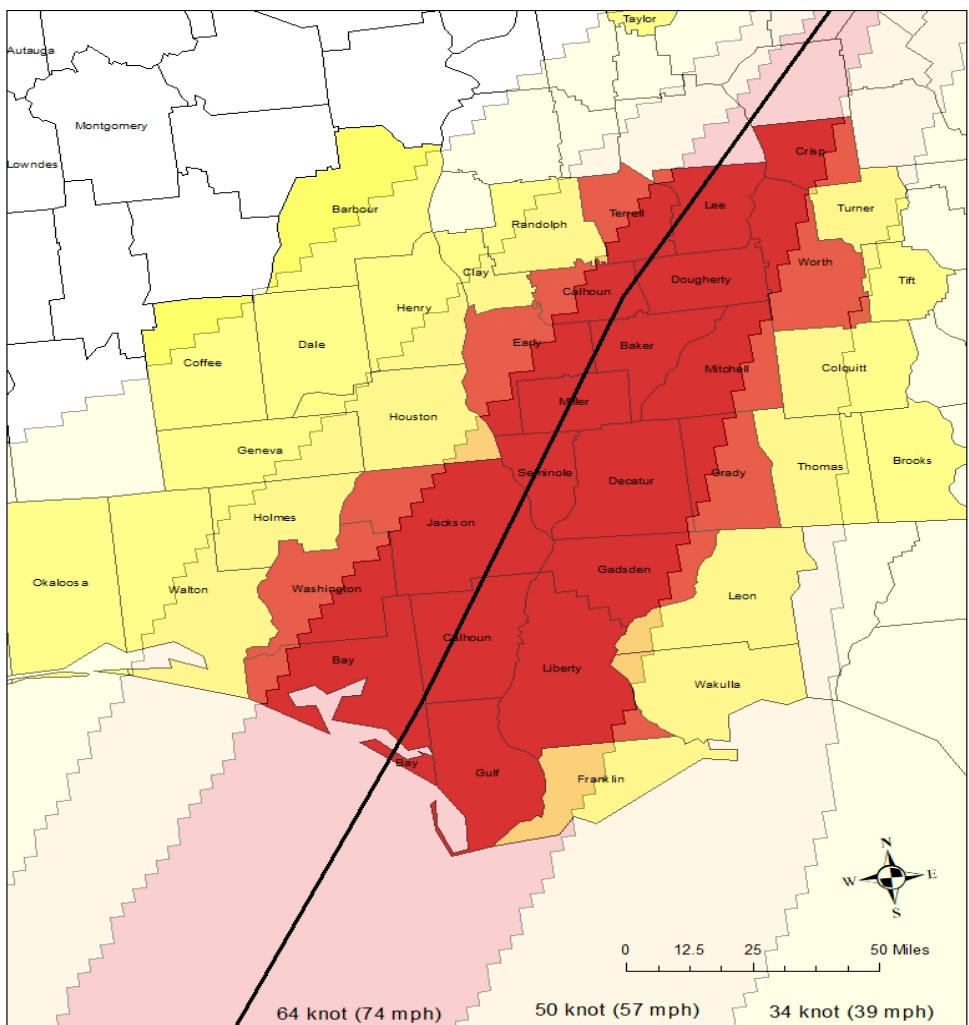
Figure 4. The track and wind swath of Hurricane Michael with Heavily Impacted counties (red) and Less Impacted counties (yellow). Less Impacted counties